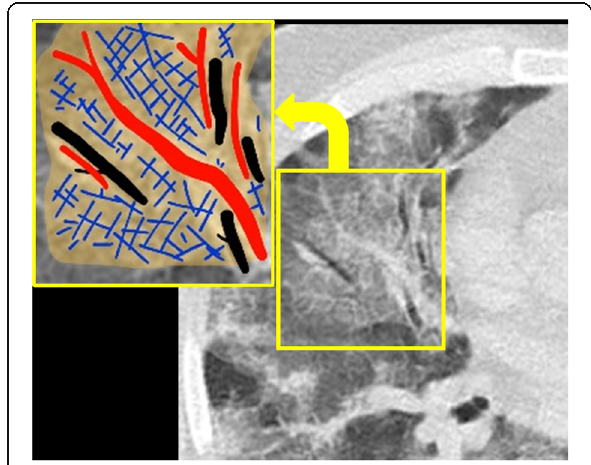
Fig. 4 Crazy paving: thickened interlobular septa (hued blue in enhanced insert) on a GGO background (highlighted in yellow) creates similar appearance to a pavement made up of disorganized paving stones. Colored in black and red are air bronchogram and pulmonary